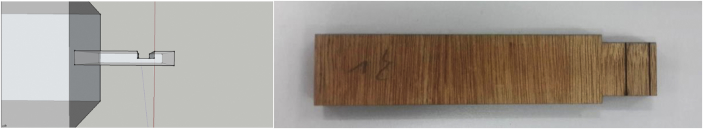
Concave part of hybrid mortise & tenon joint combining blind, interlocking, and angled in Model 4.